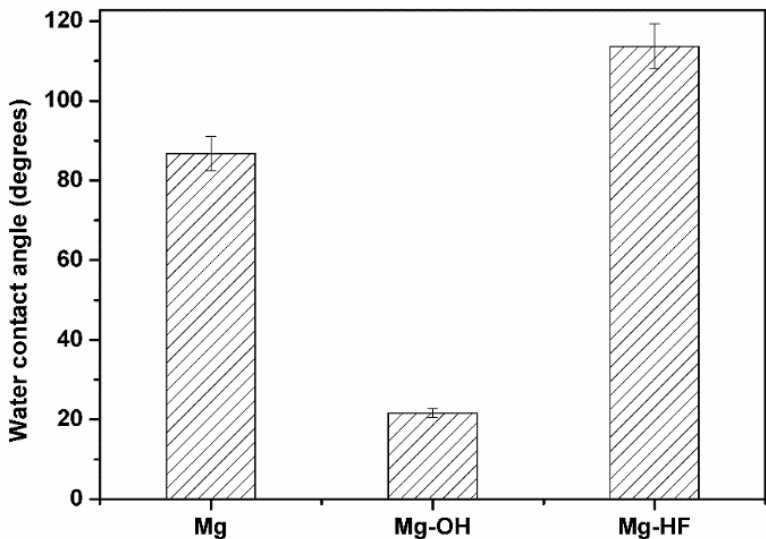
Figure 3. The water contact angles of different samples. Five parallel samples were measured and the values were averaged. The data were expressed as mean ± standard deviation (SD). The value of Mg–OH was significantly lower ( p < 0.05) than that of the pristine magnesium alloy, while the water contact angle of Mg–HF was significantly larger ( p < 0.05) than that of the pristine magnesium alloy.